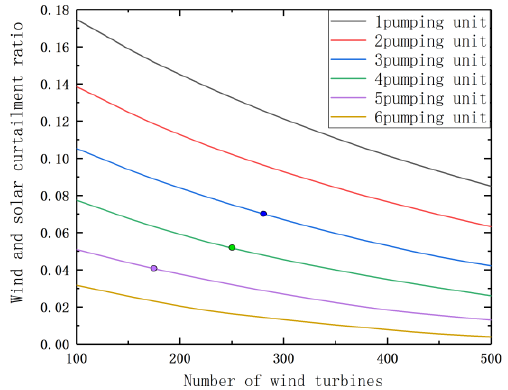
Figure 11. Expectation of insufficient power (EENS) for different capacity configuration schemes.